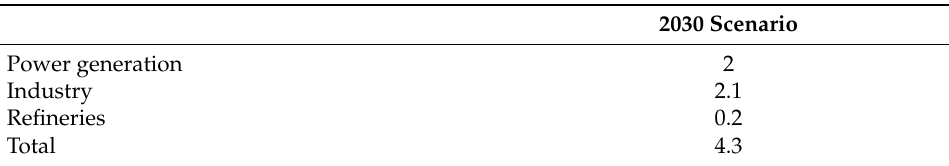
Table 6. CO 2 captured by CCS technologies (million